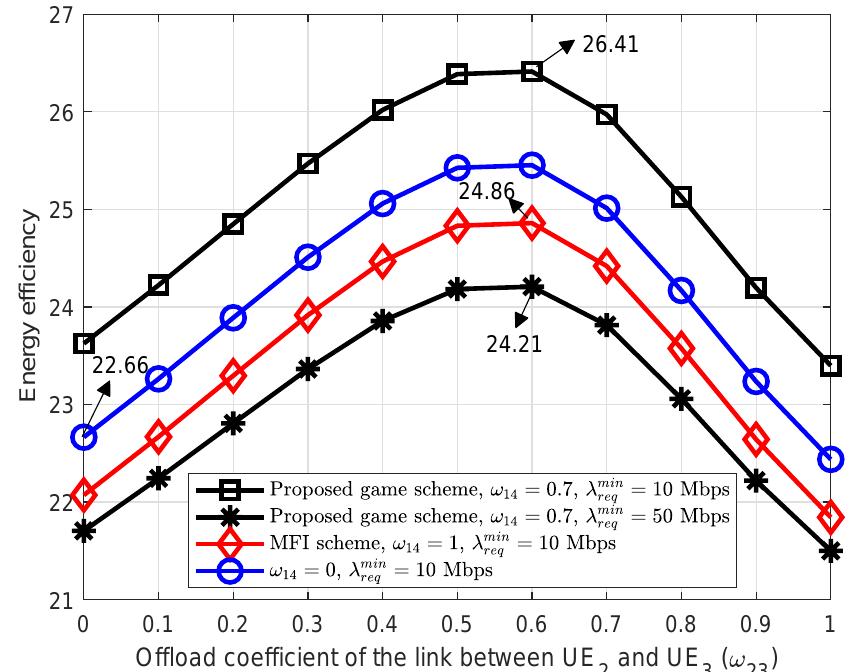
Figure 9. The energy efficiency (EE) according to offload coefficient pairs of the link between UE 2 –UE 3 ( ω 23 ) and the link UE 1 –UE 4 ( ω 14 ) when the minimum required data rate is 10 Mbps and 50 Mbps, respectively, and e hv mean = 15